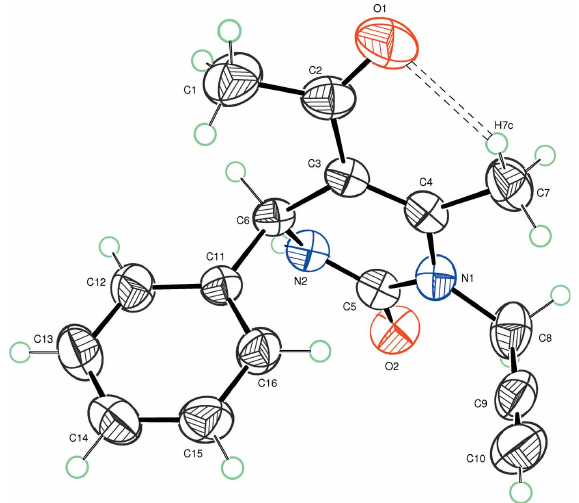
Figure 1 The molecular structure of the title compound, with displacement ellipsoids drawn at the 50% probability level. The intramolecular hydrogen bond is shown as a dashed line.